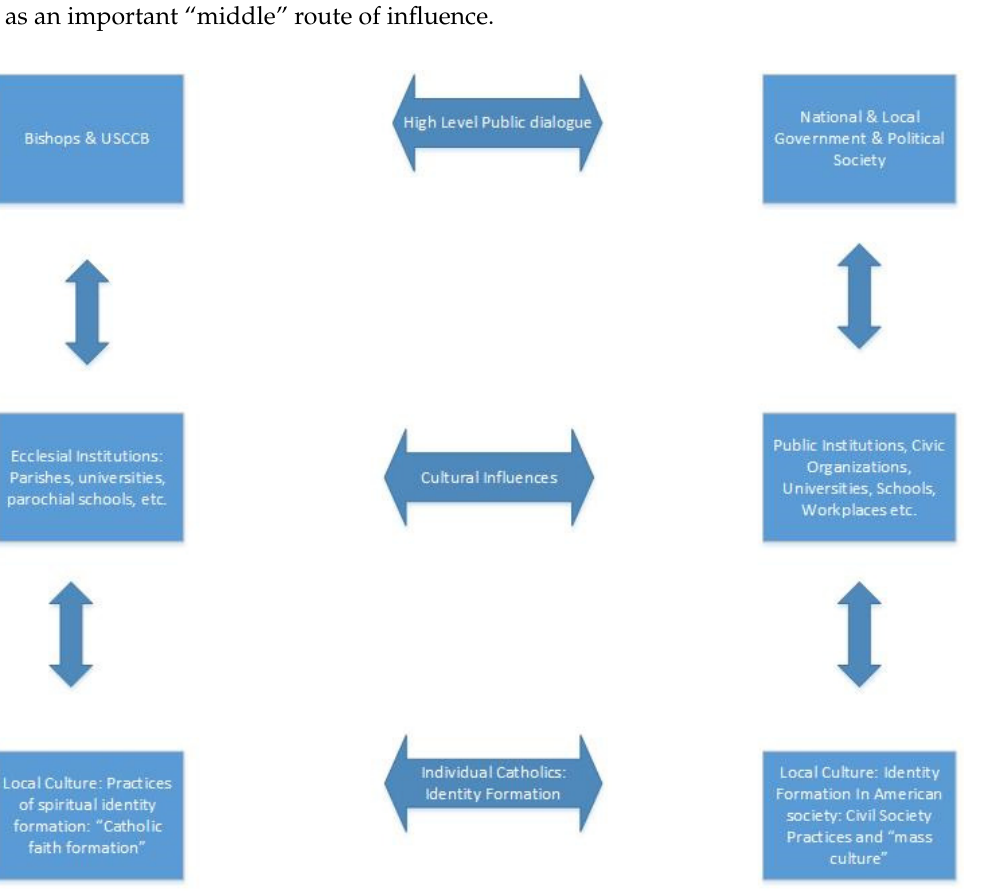
Figure 1. Public Catholicism—channels of influence between church and society.